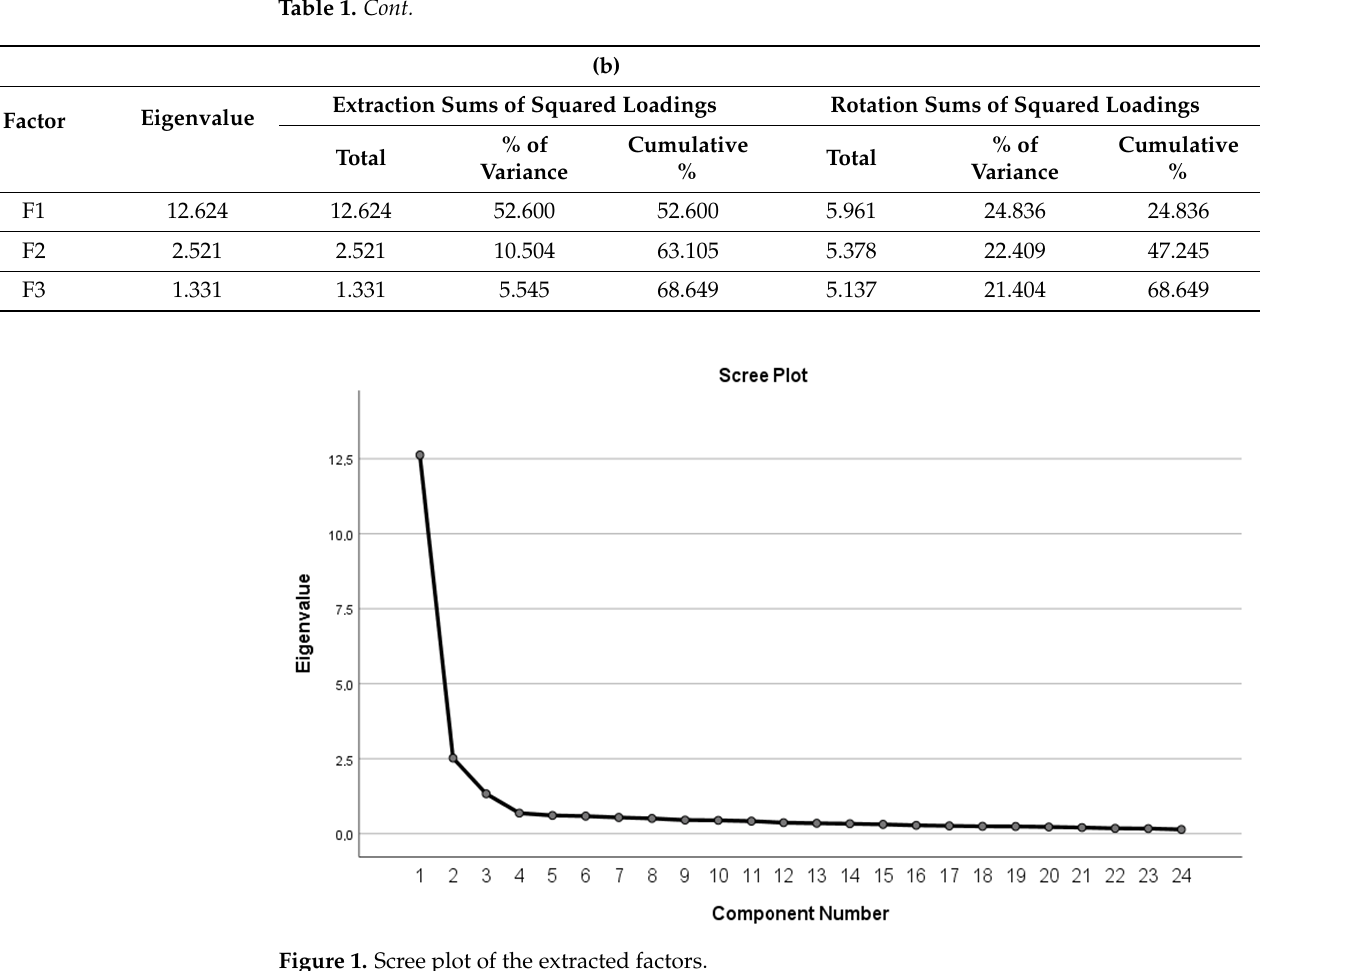
Table 1. (a). Factor structure of the CCC3 methodology. (b) Eigenvalues and variance explained.